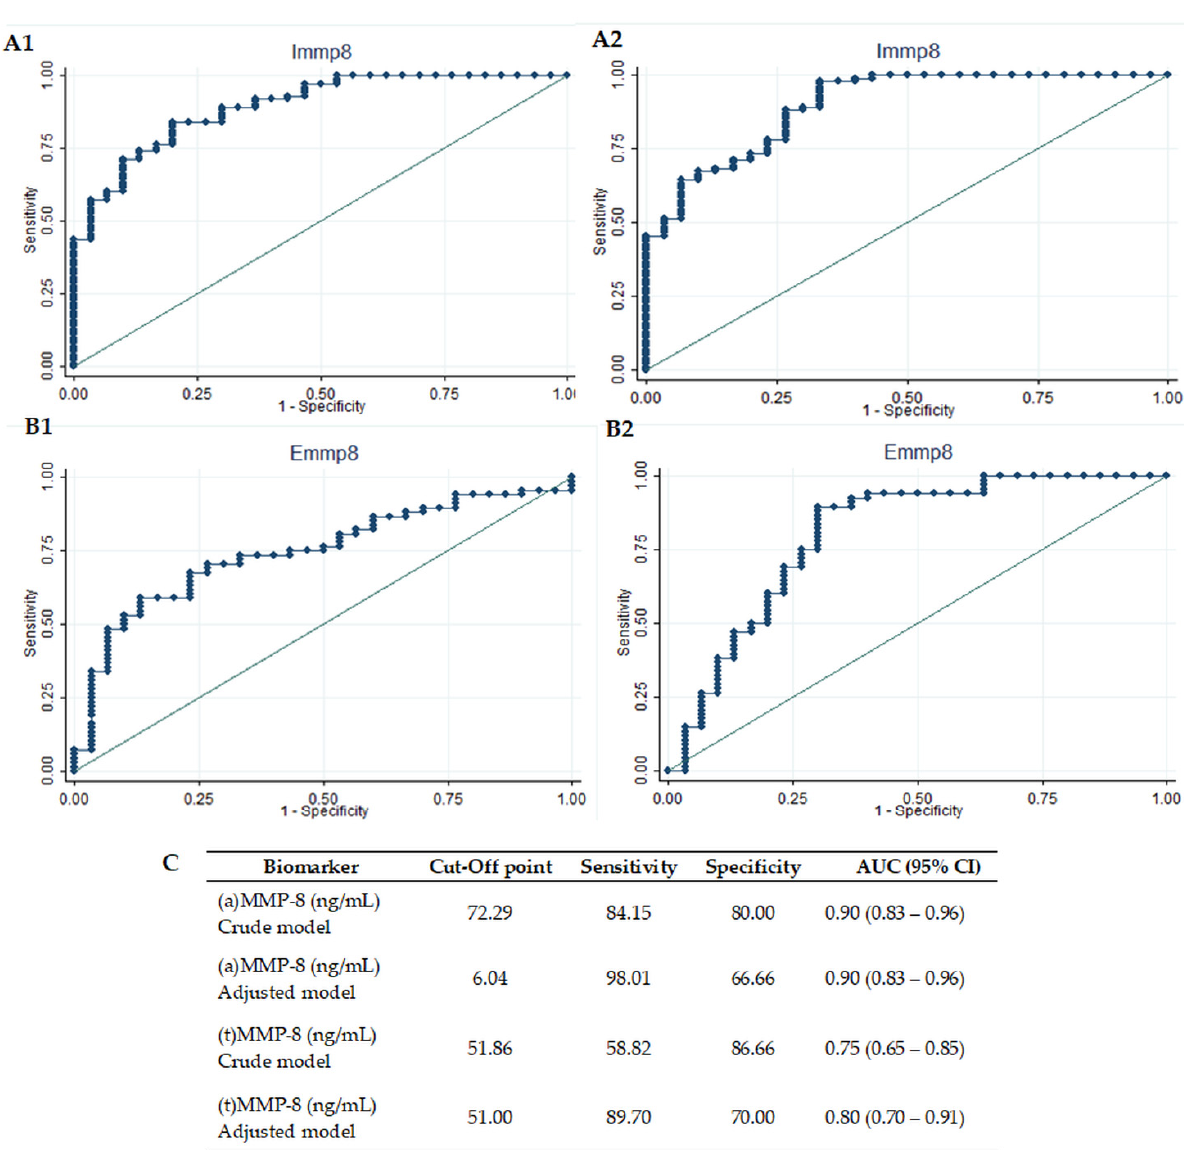
Figure 2. Diagnostic potential of MMP-8 tests to identify healthy sites. Diagnostic potential of active metalloproteinase-8 (a) MMP-8, to identify healthy from periodontitis sites, crude ( A1 ) and adjusted ( A2 ) models; diagnostic potential of (t) MMP-8 to identify healthy from periodontitis sites, crude ( B1 ) and adjusted ( B2 ) models; ( C ) sensitivity, specificity, and cut-off points of (a) MMP-8 and (t) MMP-8 diagnostic potential to identify healthy from periodontitis sites. AUC: area under the curve. CI: confidence interval. (a) MMP-8: active matrix metalloproteinase-8; (t) MMP-8: total matrix metalloproteinase-8. Immp8: IFMA MMP-8; Emmp8: ELISA MMP-8.